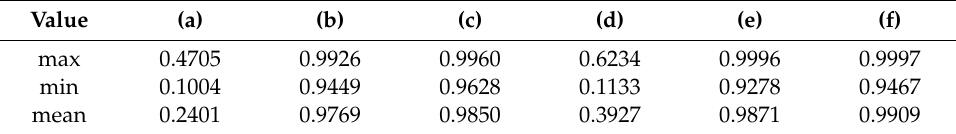
Table 3. The probabilities of the input be classified to one type.